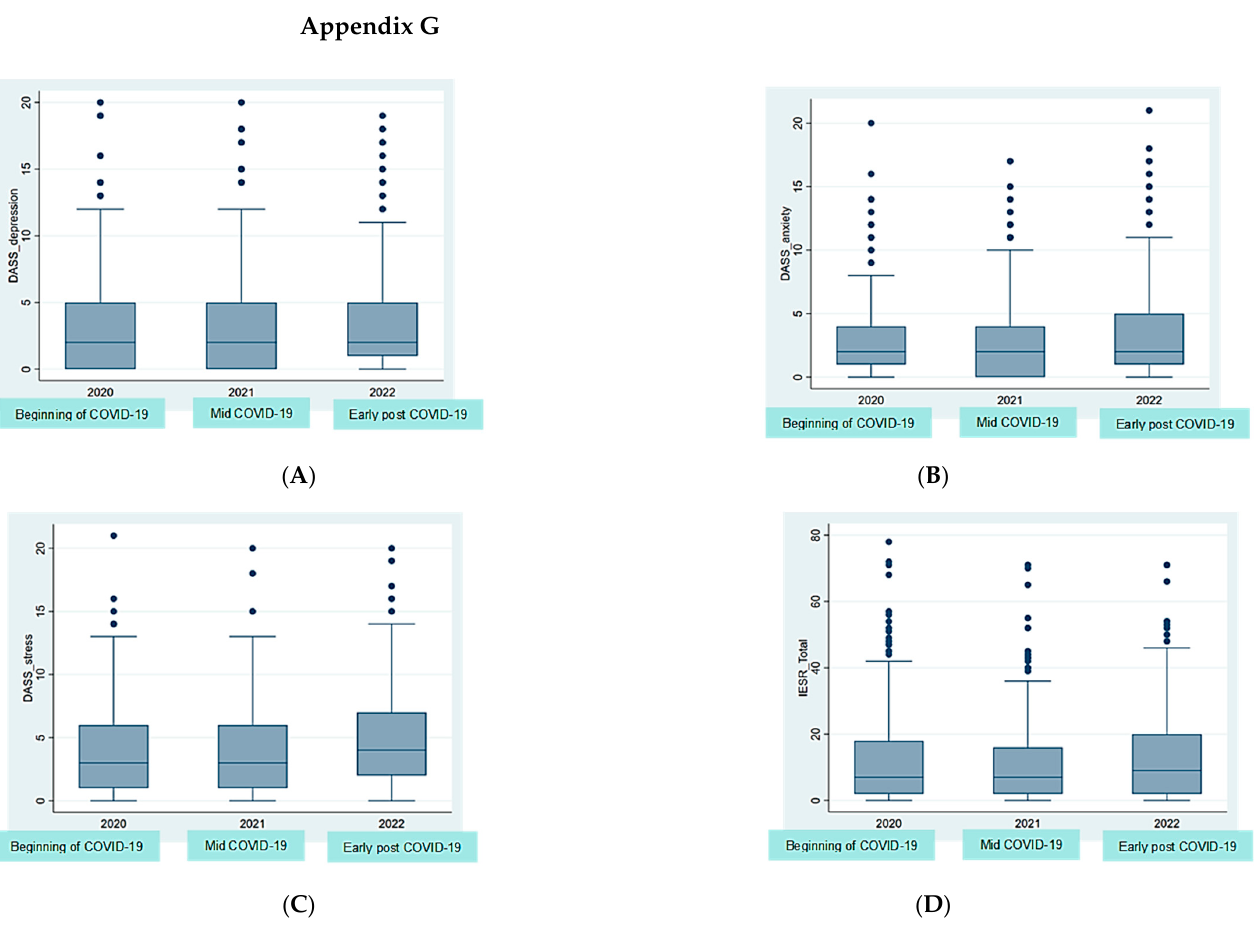
Figure A3. MHO scores (( A ) Depression, ( B ) Anxiety, ( C ) Stress and ( D ) PTSD of clinical concern) in all ED HCWs in each cohort.